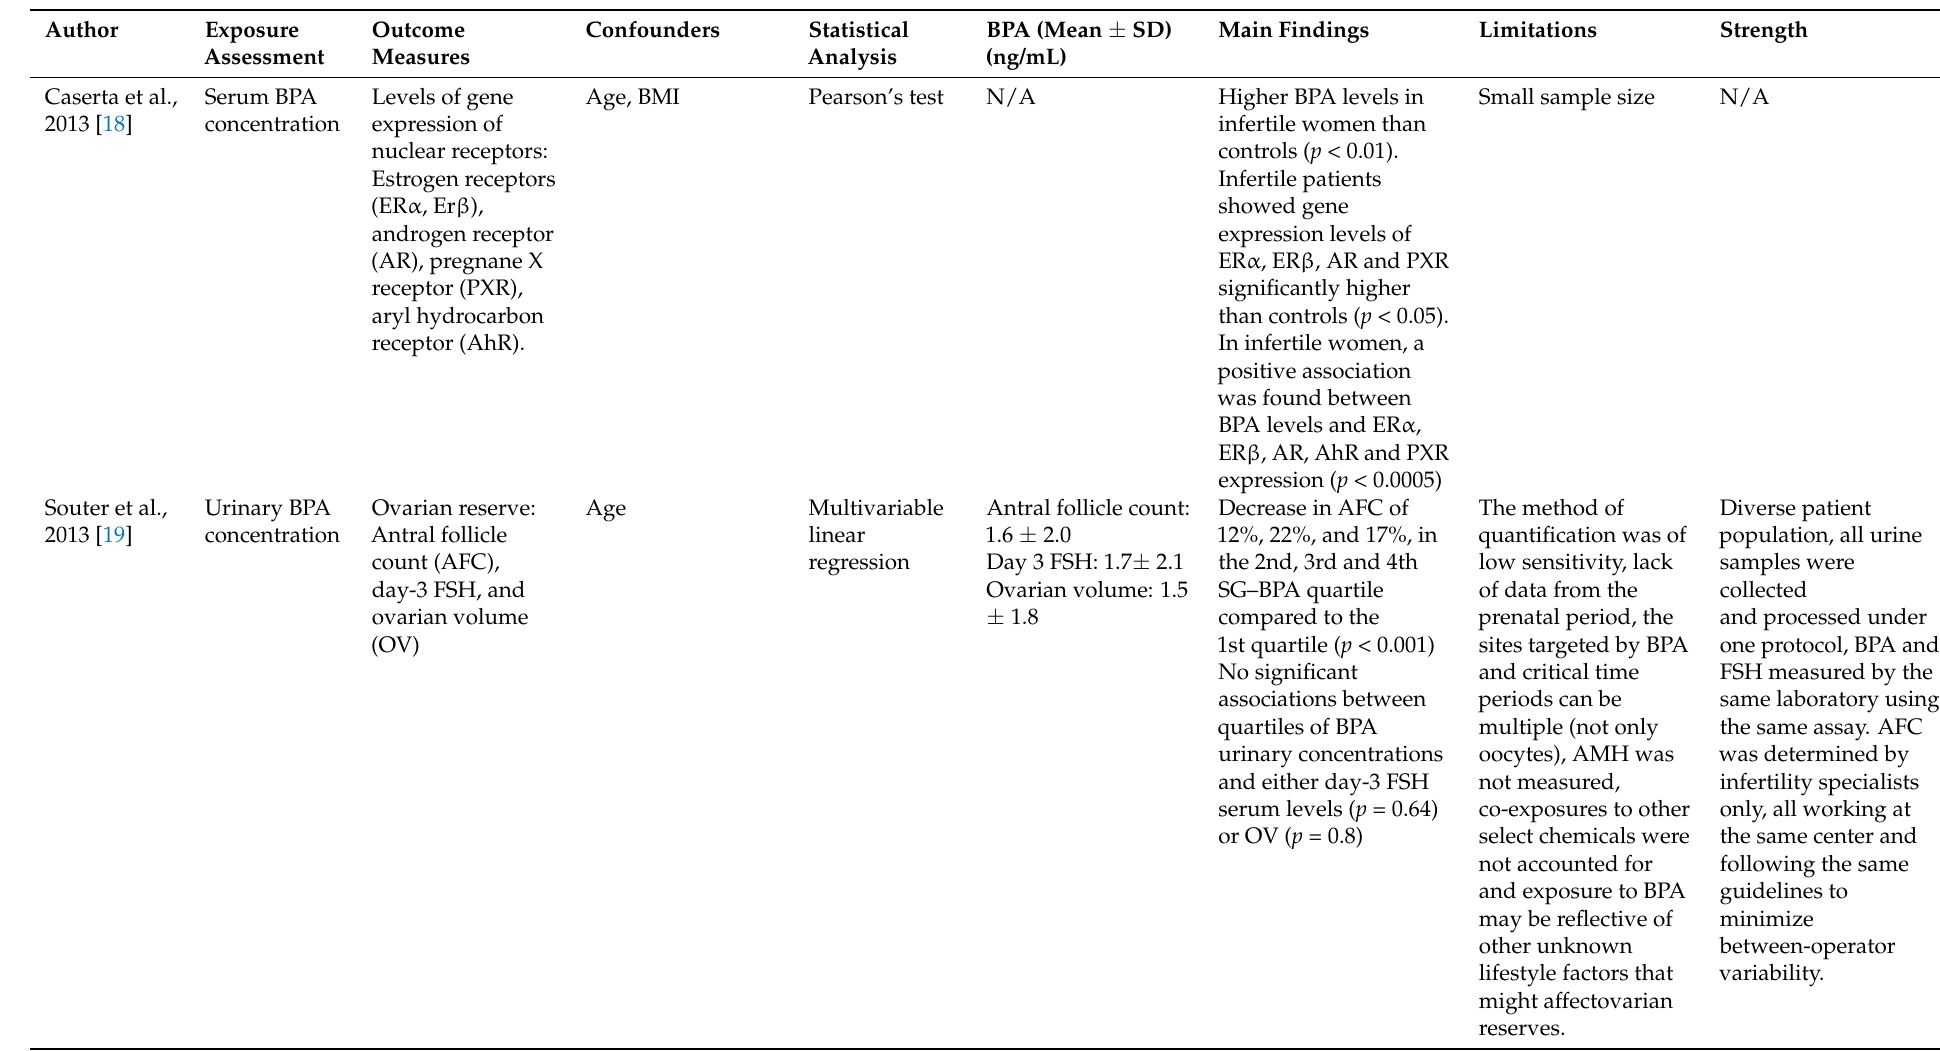
Table 2. Bisphenol-A and general